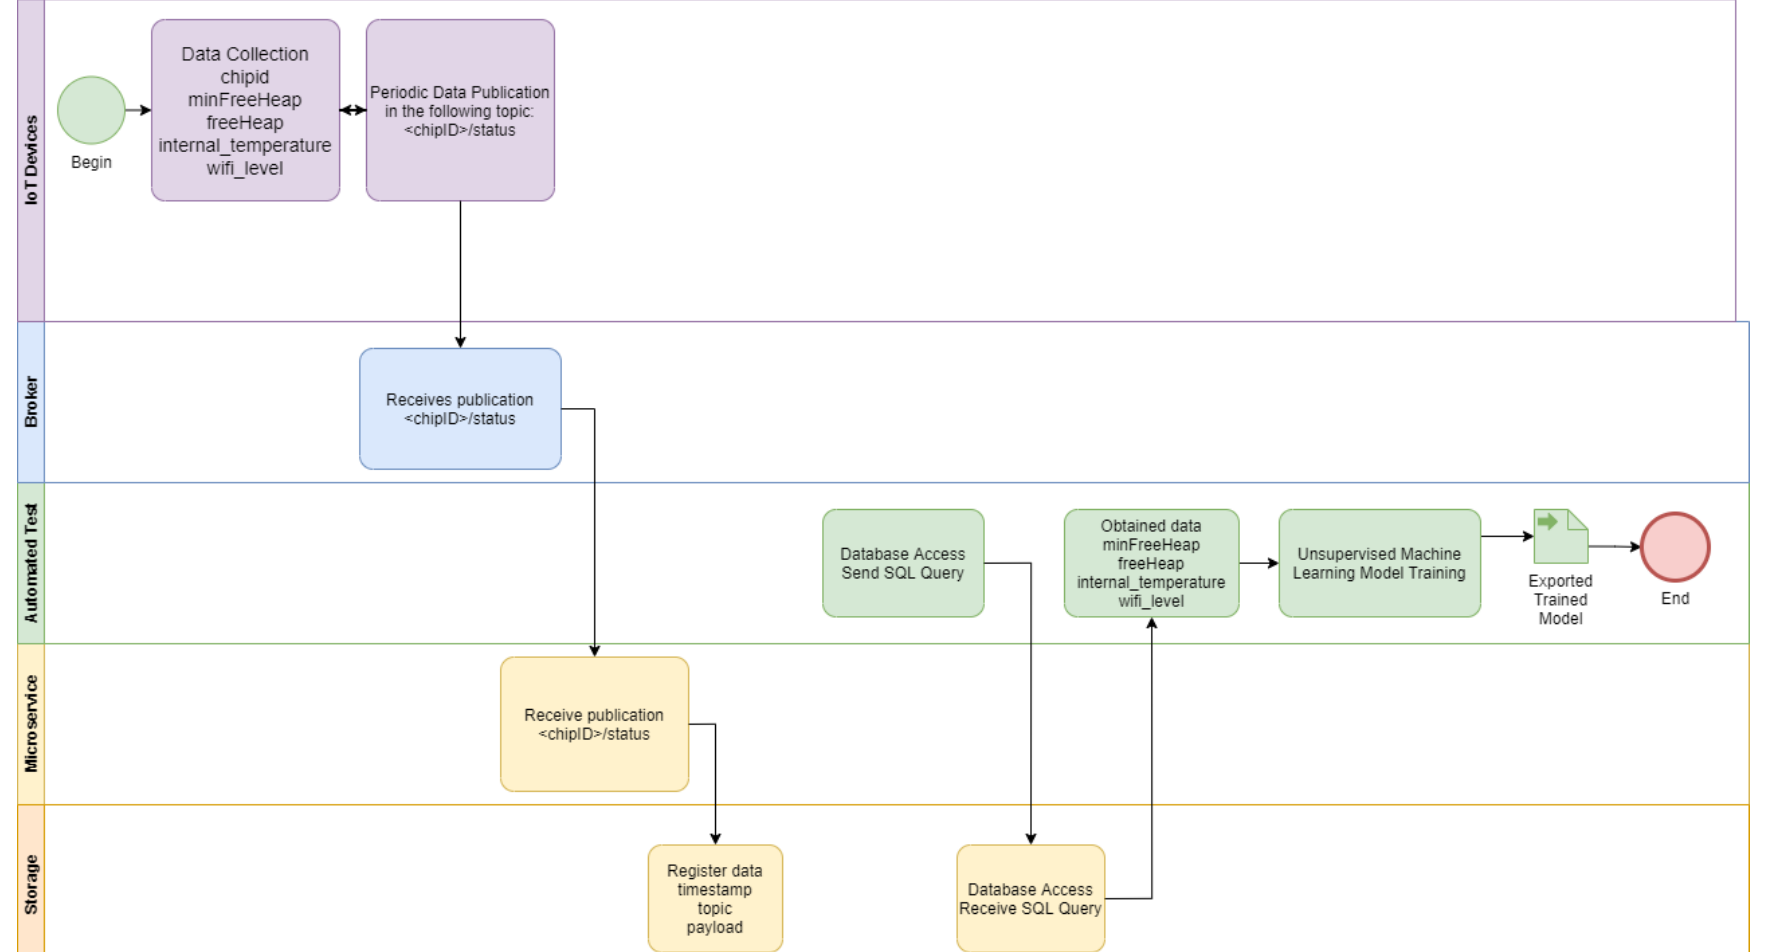
Figure 3. BPMN diagram of the training phase of the automated